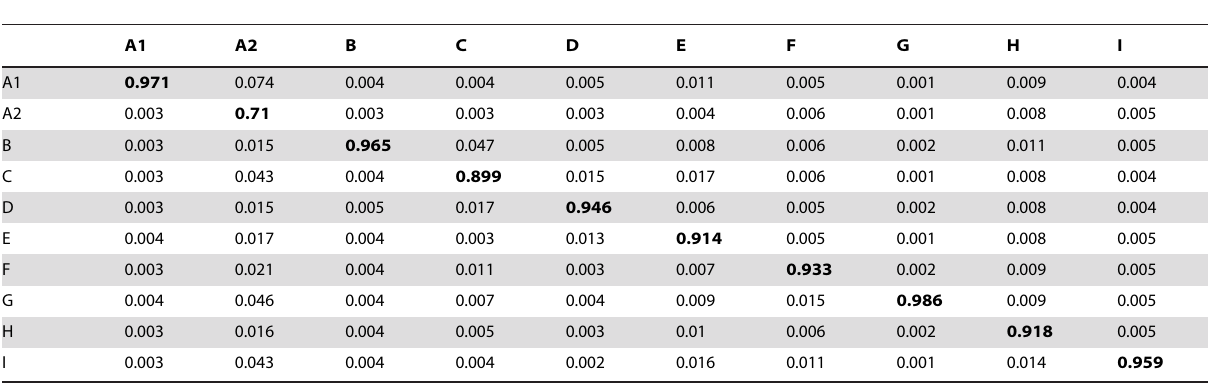
Table 3. Mean estimates of the distribution of recent migration rates ( m ) calculated using B AYESASS + [28], given as the proportion of migrant individuals per population per